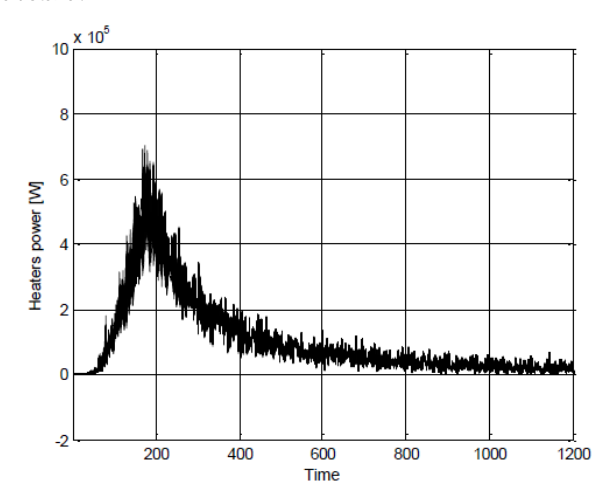
Fig. 26. Heaters power profile of trajectories belonging to cluster